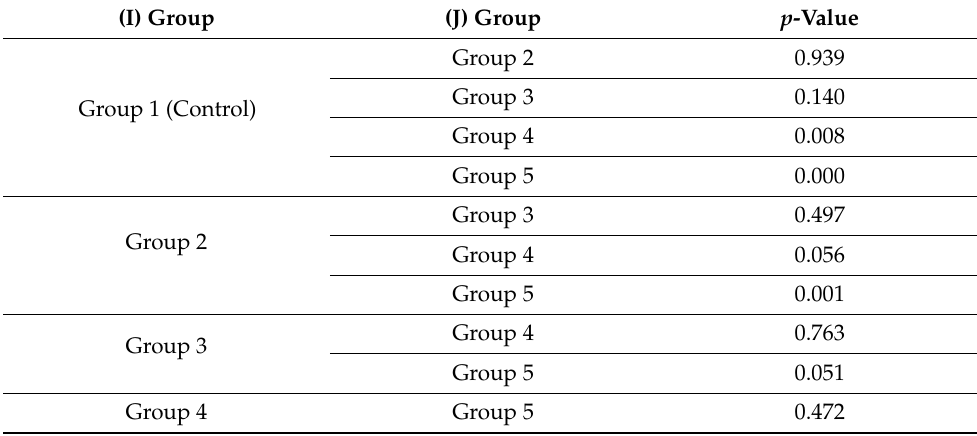
Table 2. Post hoc Tukey’s multiple comparison test between groups for flexural strength.